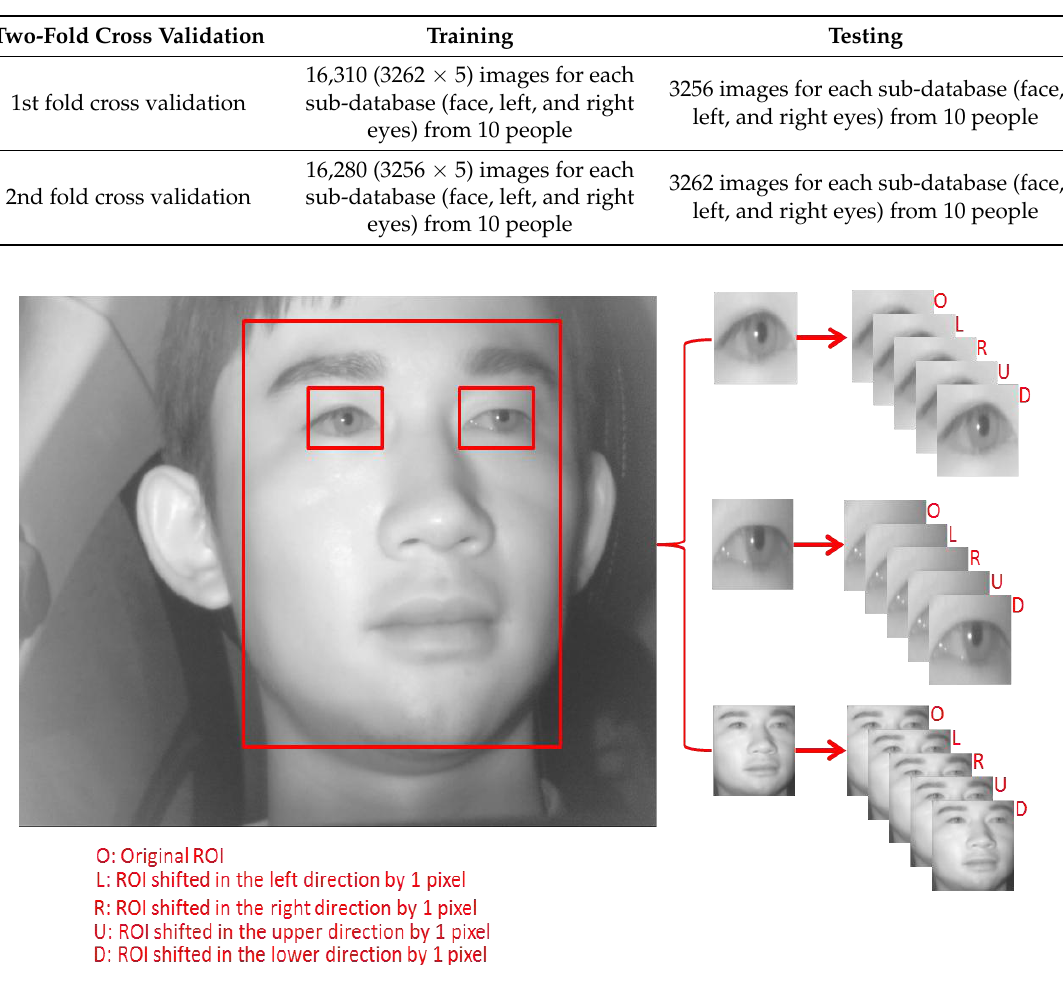
Figure 11. Augmented images obtained from the original ROI image.